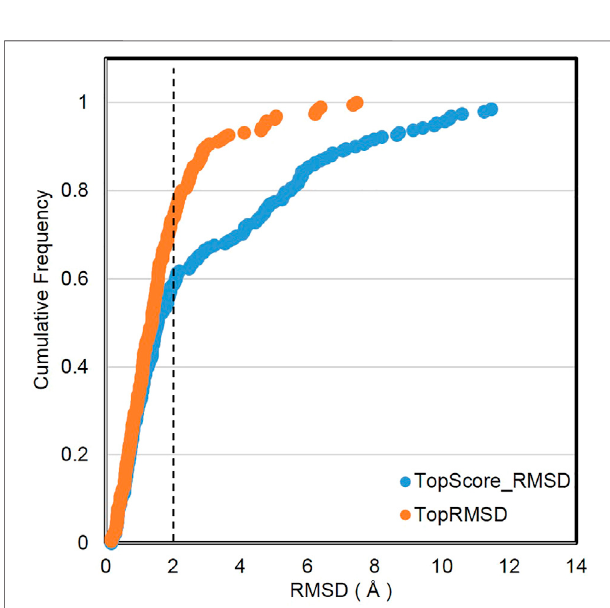
FIGURE 6 | Sample power by comparing cumulative frequencies of TopScore_RMSD and TopRMSD, compared to the methods evaluated in CASF-2013 and